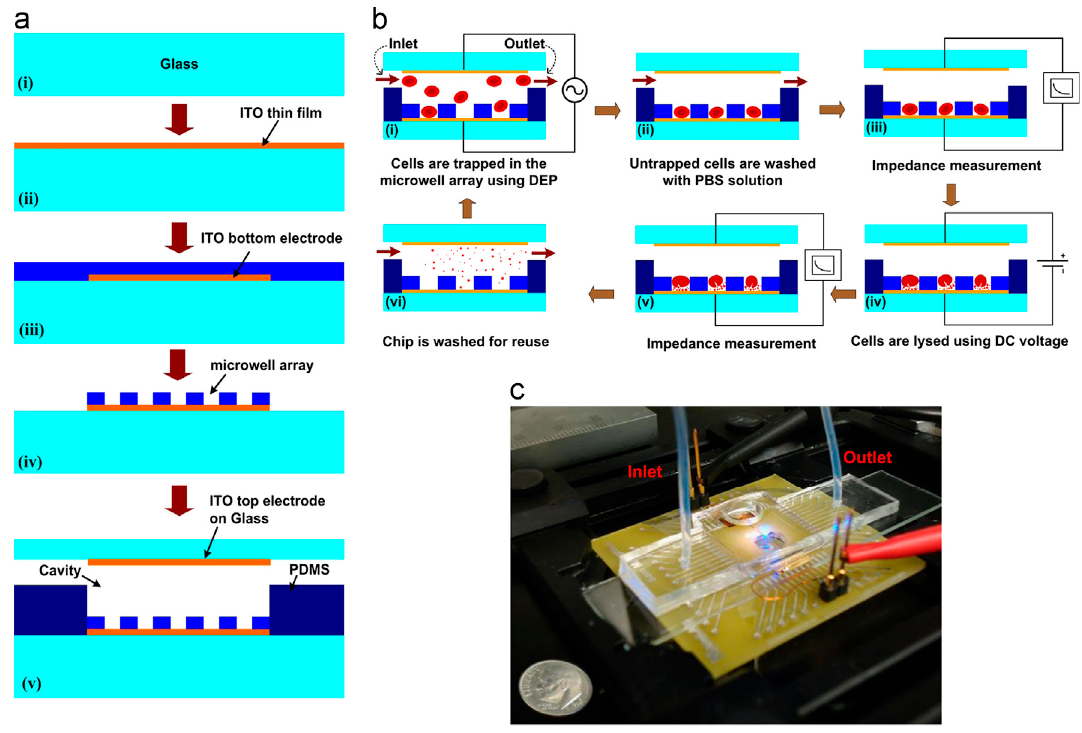
Figure 13. Electrical cell lysis device: ( a ) fabrication protocol of the device; ( b ) working principle of the device; and ( c ) microfluidic device used in the study for lysing red blood cells. Reproduced with permission from